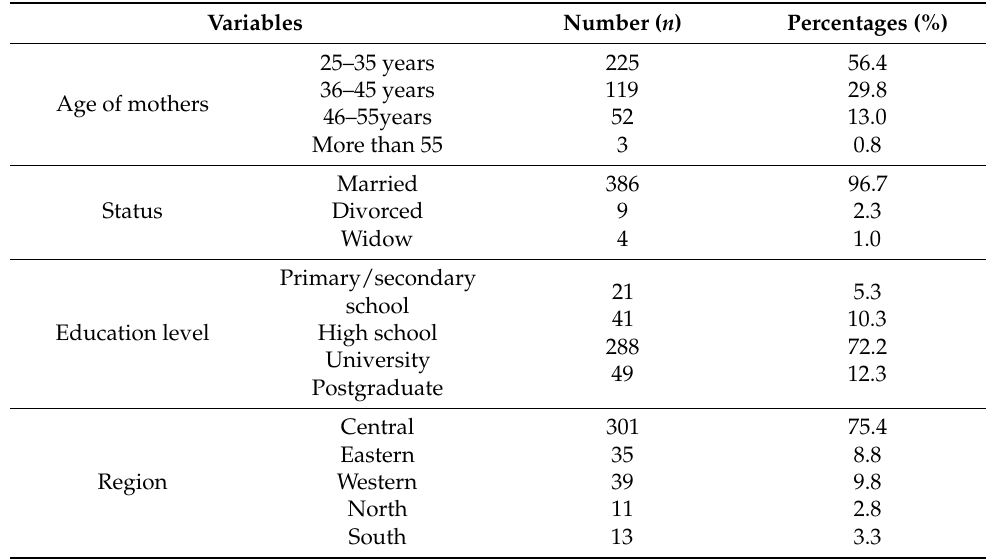
Table 1. Demographic data of respondents ( n =